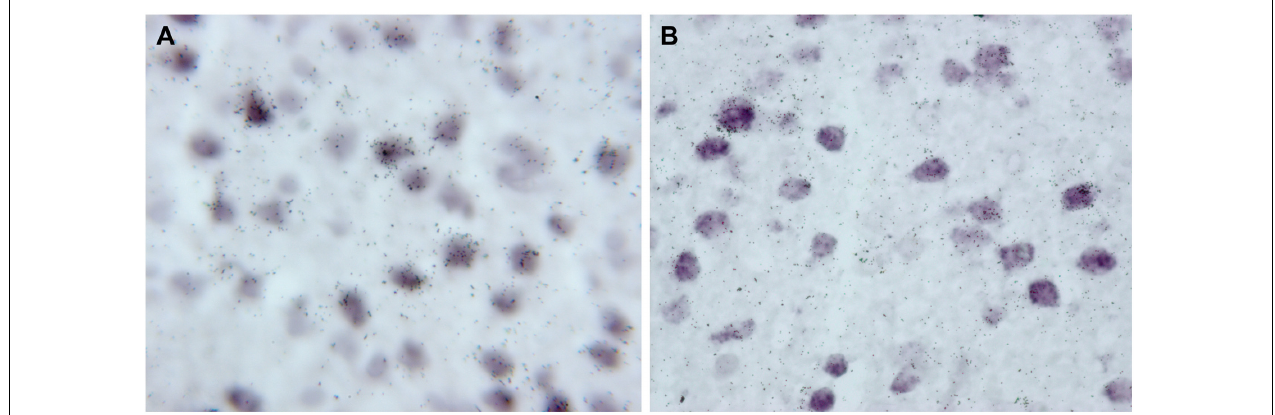
FIGURE 1 | High magnification photomicrographs showing the presence of 5-HT 1A receptor mRNA ( 33 P-labeled oligonucleotides) in pyramidal cells, identified by the presence of VGLUT1 mRNA (Dig-labeled oligonucleotides). Both images were acquired from the same experiment and correspond to deep layers of mPFC cingulate area. (A) Was captured in 2003 with a Nikon Eclipse E1000 microscope (Nikon, Tokyo, Japan) using a digital camera (DXM1200 3.0; Nikon) and analySIS Software (Soft Imaging System GmbH, Germany); (B) was captured in 2017 with a Zeiss Axioplan microscope equipped with a digital camera (XC50, Olympus) with Olympus CellSens Entry software.